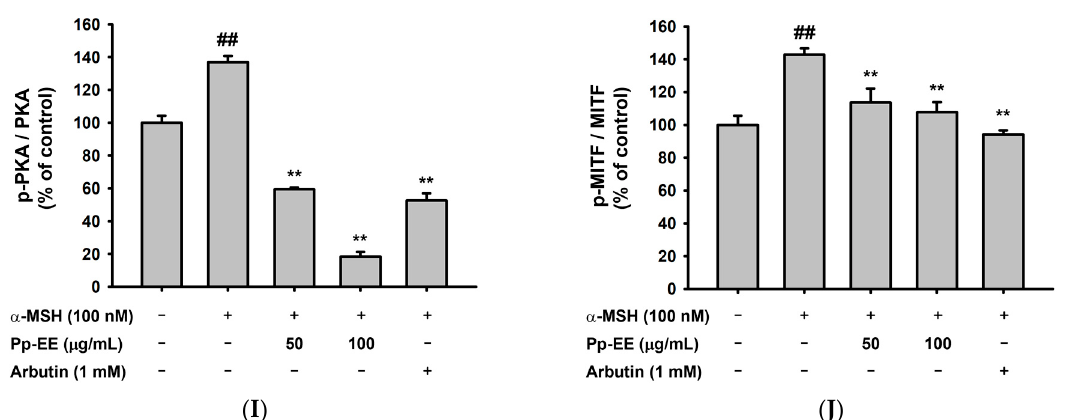
Figure 4. Anti-melanogenesis activity of Pp-EE in melanocytes. ( A ) The cytotoxicity of Pp-EE in B16F10 cells was assessed using the MTT assay. ( B , C ) The effects of Pp-EE on melanin content and secretion in B16F10 cells were evaluated using the melanin generation assay. ( D – G ) The mRNA levels of MITF , tyrosinase , TYRP-1 , and TYRP-2 were checked in B16F10 cells treated with Pp-EE or arbutin using real-time PCR. The fold increase represents the ratio of the increased mRNA expression level of α -MSH-, Pp-EE-, or arbutin-treated groups to the mRNA expression level of the normal group. ( H ) The total and phosphorylated forms of PKA and MITF were measured in an immunoblotting analysis. ( I , J ) The relative intensities of the immunoblots were determined using ImageJ. All the results are expressed as the mean ± standard deviation. ## p < 0.01 compared with the normal group, and * p < 0.05, ** p < 0.01 compared with the control group.